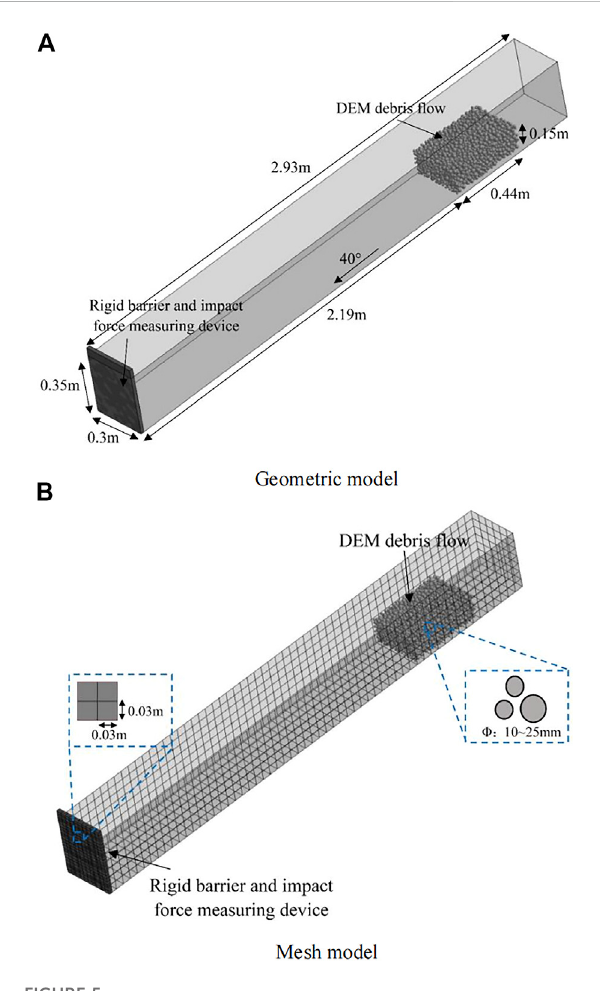
FIGURE 5 The coupled DEM-FEM numerical model of debris fl ow impact (A) Geometric model (B) Mesh model.